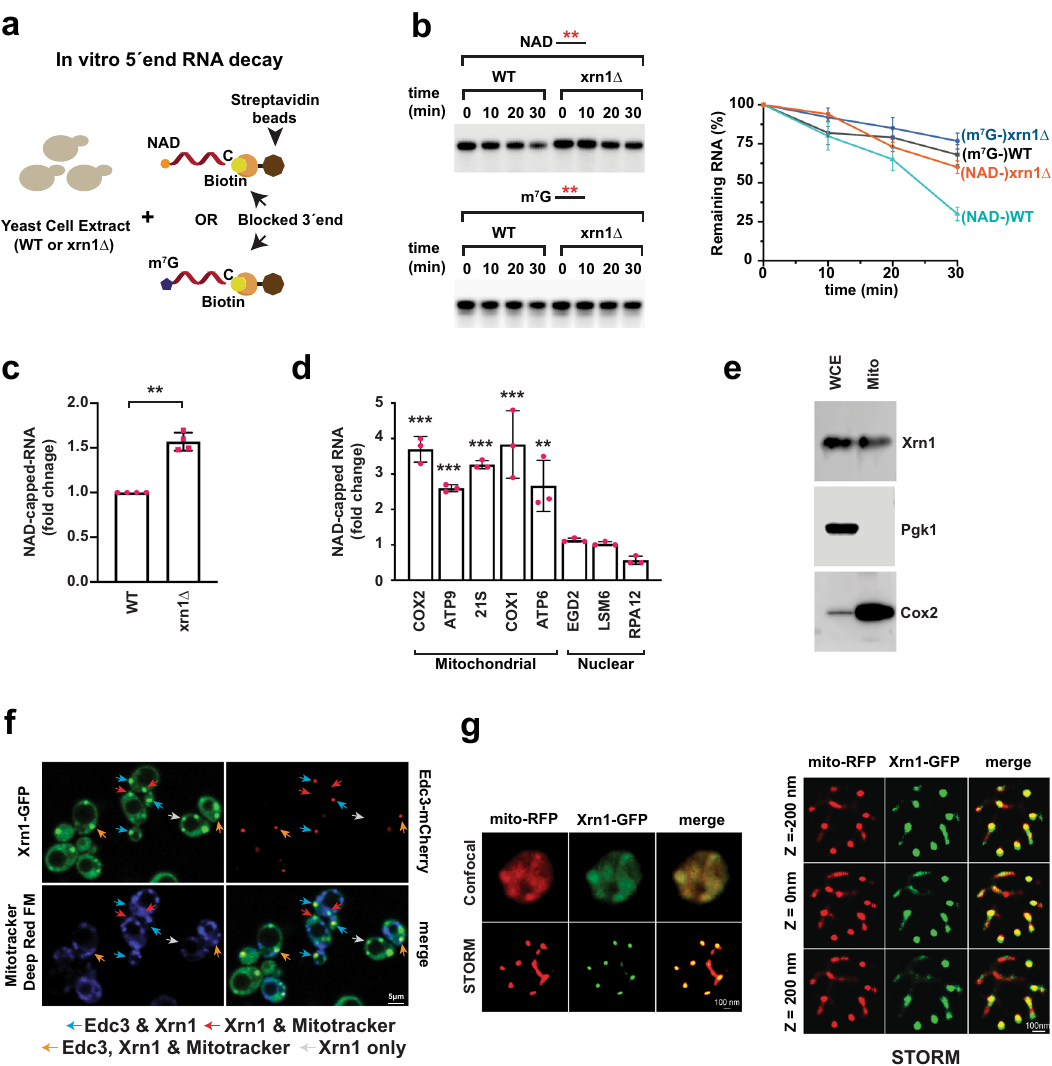
Fig. 3 Xrn1 deNADs NAD-capped RNAs in cells. a Schematic illustration of in vitro 5 ′ -end RNA decay. b Time-course decay analysis of uniformly 32 P-labeled m 7 G- or NAD-capped RNA in the presence of cell extract prepared from WT or xrn1 Δ strains. The remaining RNA was quanti fi ed and plotted from n = 3 independent experiments (±SD denoted by error bars). Labeling as in the legend to Fig. 2. c Total NAD-capped RNA levels from WT and xrn1 Δ were detected by NAD-capQ. Data represents average from n = 4 independent experiments. Error bars represent ±SEM; two sided unpaired t test; ** p = 0.0036). d qRT-PCR quanti fi cation of NAD-capped mRNA. NAD-capped RNA was enriched by NAD-capture, eluted from the beads, reverse transcribed and detected with gene-speci fi c primers. Data are presented relative to the WT cells set to 1 and derived from n = 3 independent NAD-capture experiments; mean ± SEM; two-sided unpaired t test; ** p < 0.001, *** p < 0.0001. e Puri fi ed mitochondria derived from a strain harboring Xrn1 with a C-terminus Strep-tag II was analyzed by Western blot analysis with an anti-Strep-tag antibody. Western blotting analysis of whole cell extract (WCE) and